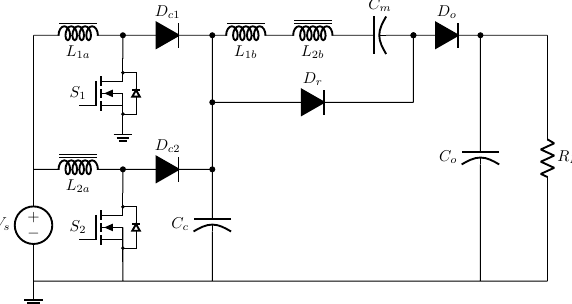
Figure 6. General Setup of Interleaved